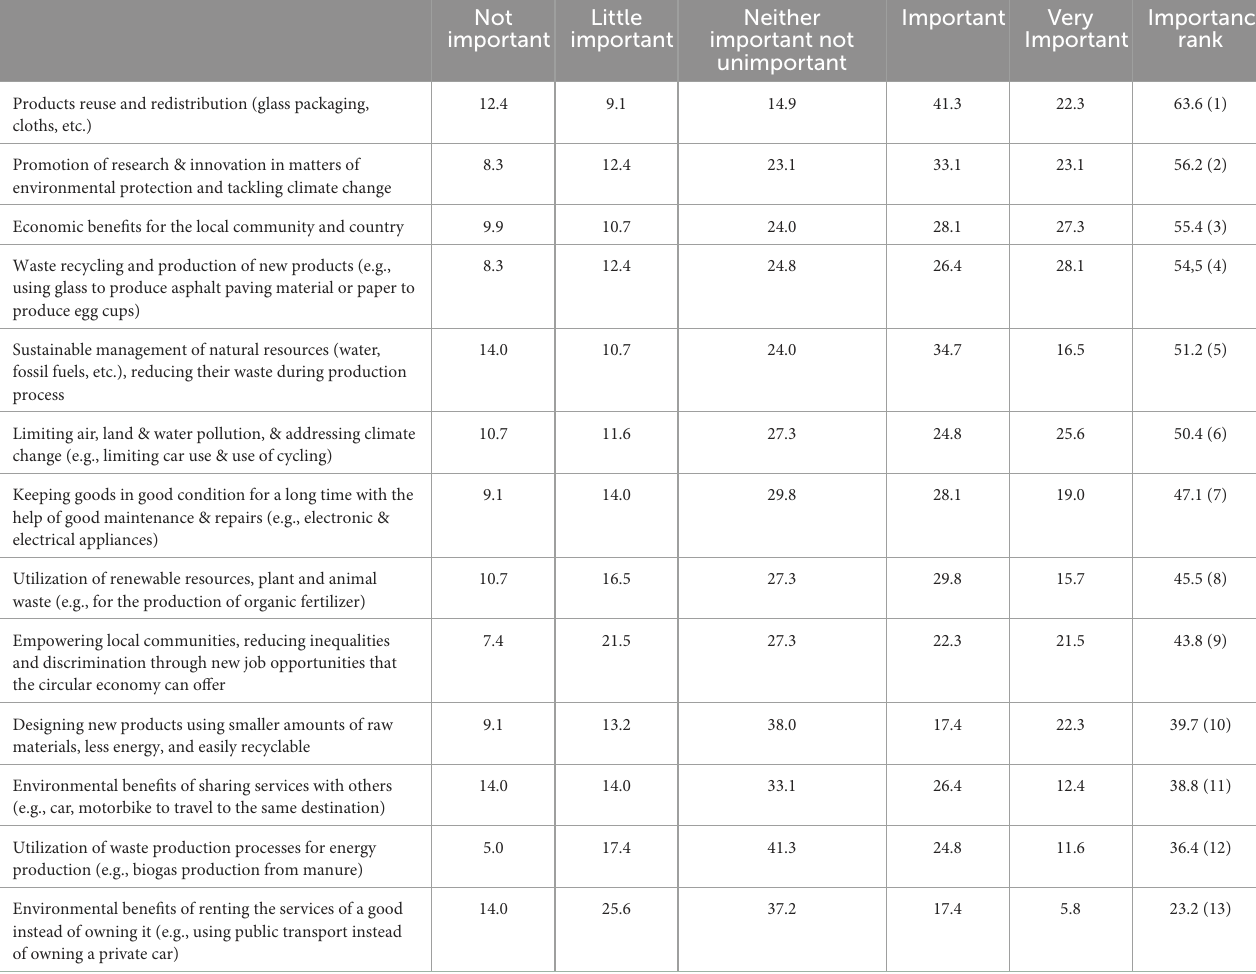
TABLE 1 Students’ attitudes toward a series of circular and sustainable practices in percentage ( N = 121).